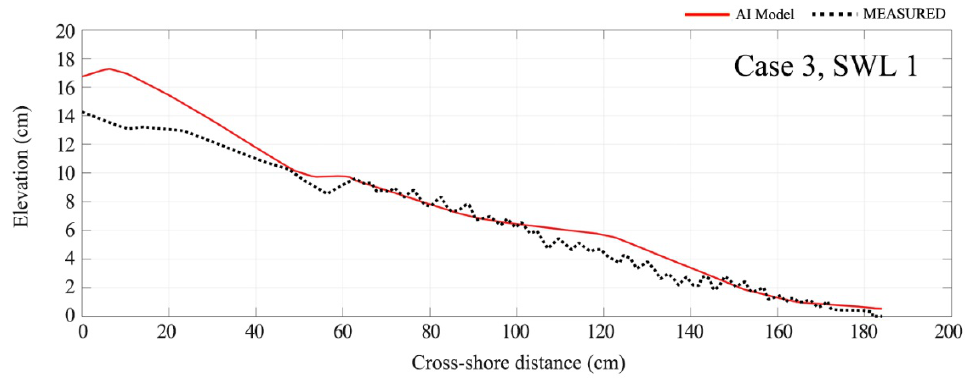
Figure 18. Case 3 SWL 1 comparison of the ANN prediction and measured from the physical test.